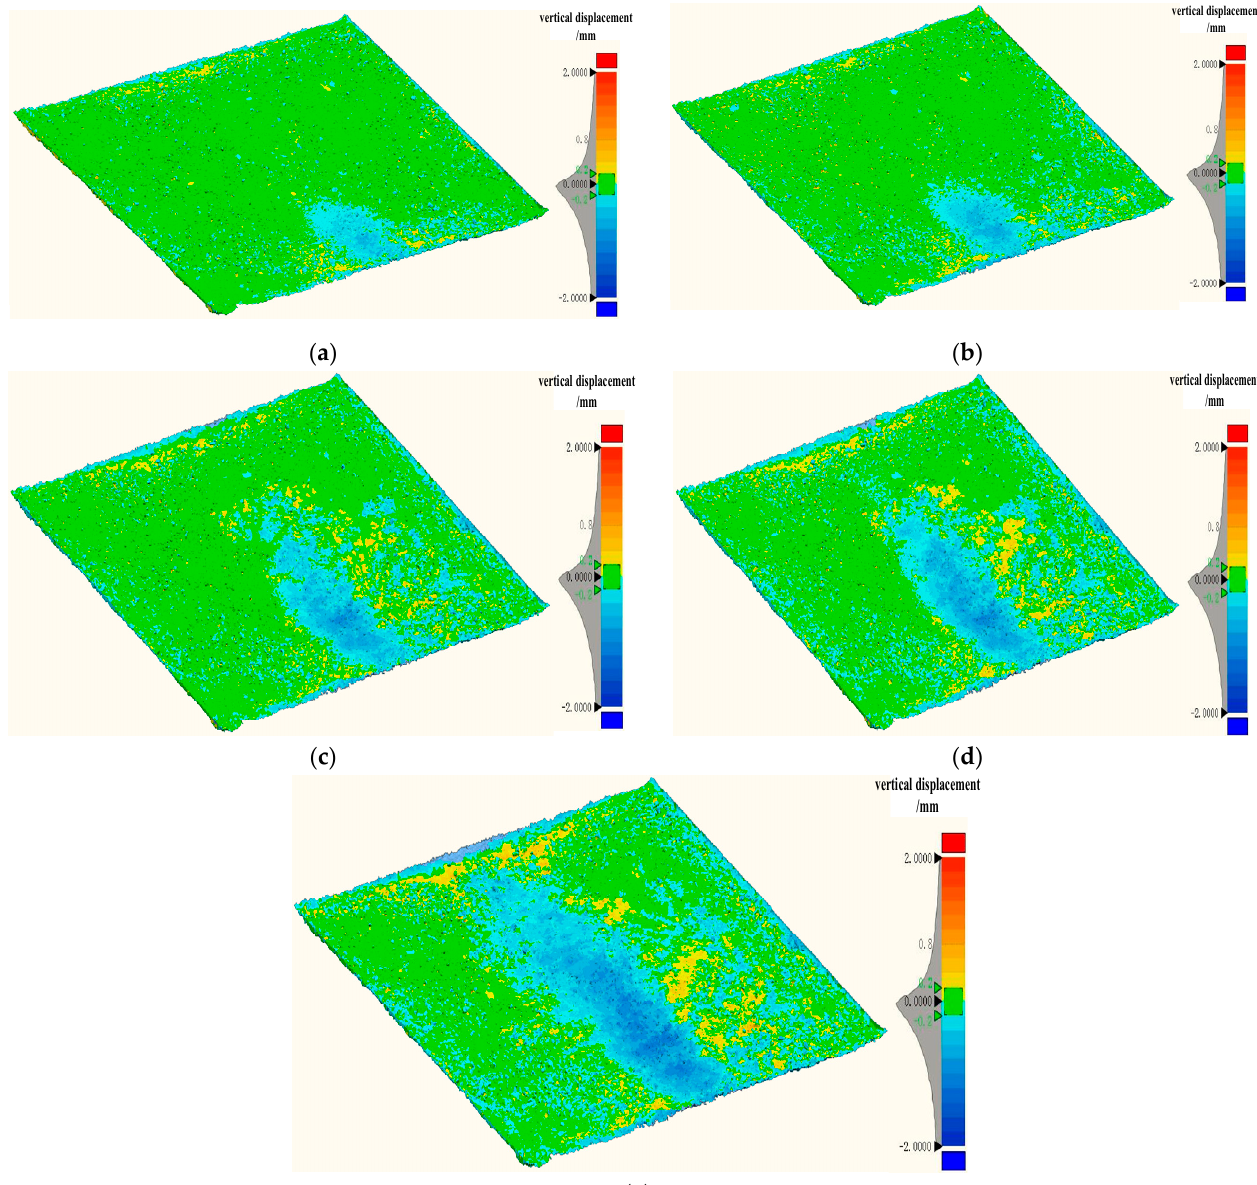
Figure 6. Cloud map of cumulative settlement of the model: ( a ) first mining; ( b ) second mining; ( c ) third mining; ( d ) fourth mining; ( e ) fifth